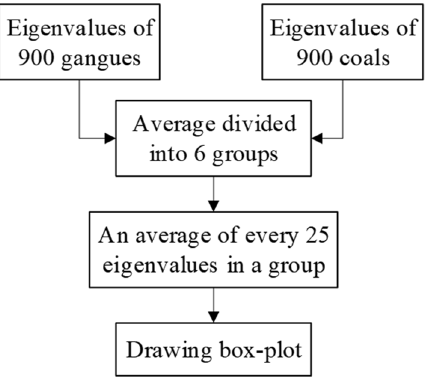
Figure 7. Eigenvalue processing